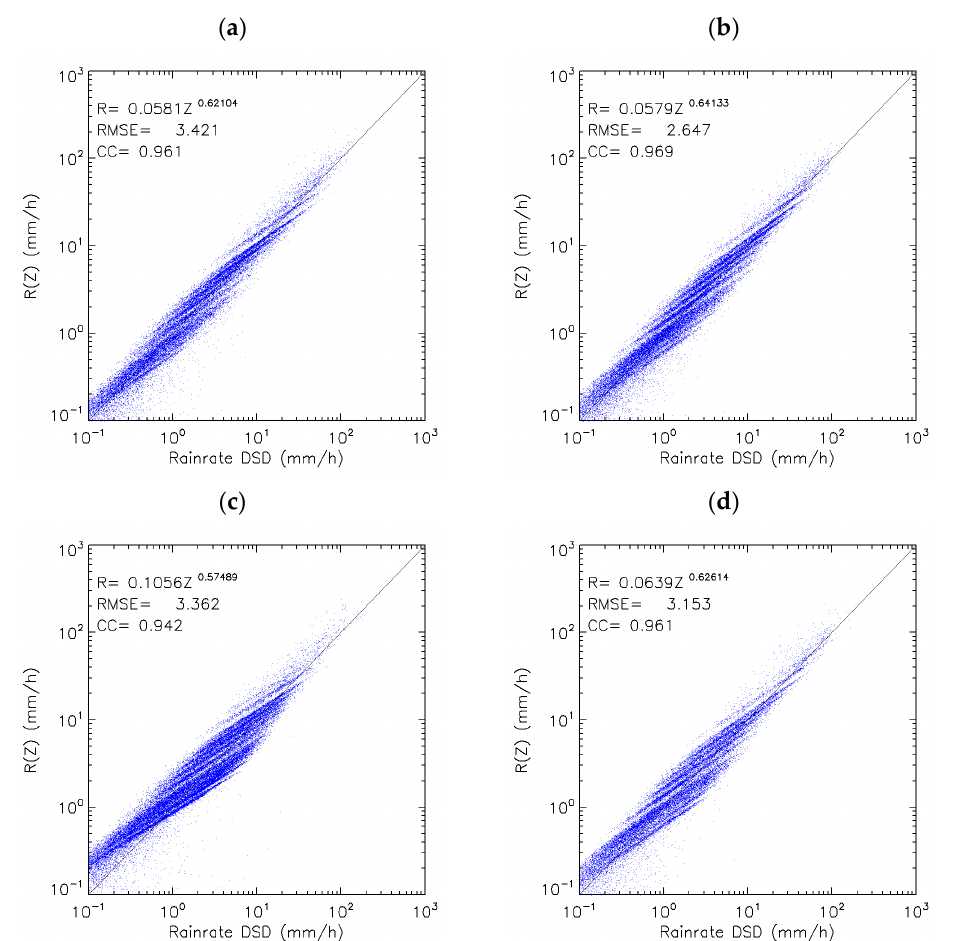
Figure 11. The scatter plots of rain rate measured by DSD and R(Z) relations were obtained from DSDs at ( a ) BOS, ( b ) BUS, ( c ) CPO, and ( d ) JIN sites. The legend shows the Z-R relation, root mean square error (RMSE), and cross-correlation coefficient (CC).